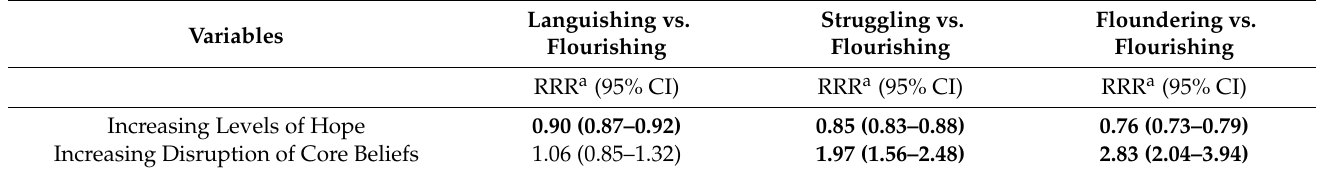
Languishing vs. Struggling vs. Floundering vs. Flourishing Flourishing